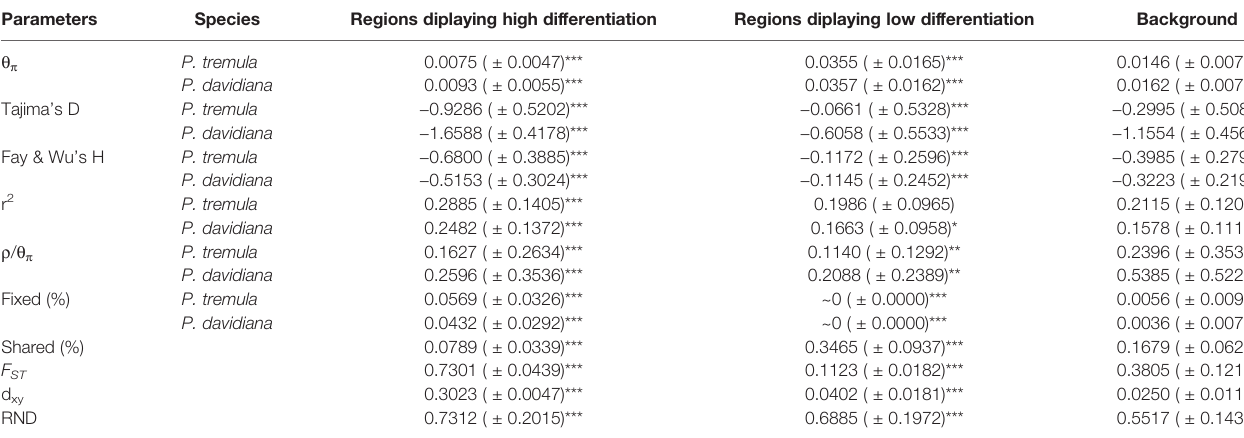
TABLE 3 | Summary statistics comparing regions displaying extreme genetic differentiation with the rest of the genomic regions in both P. tremula and P. davidiana (the mean ± standard deviation values are shown). Parameters Species Regions diplaying high differentiation Regions diplaying low differentiation